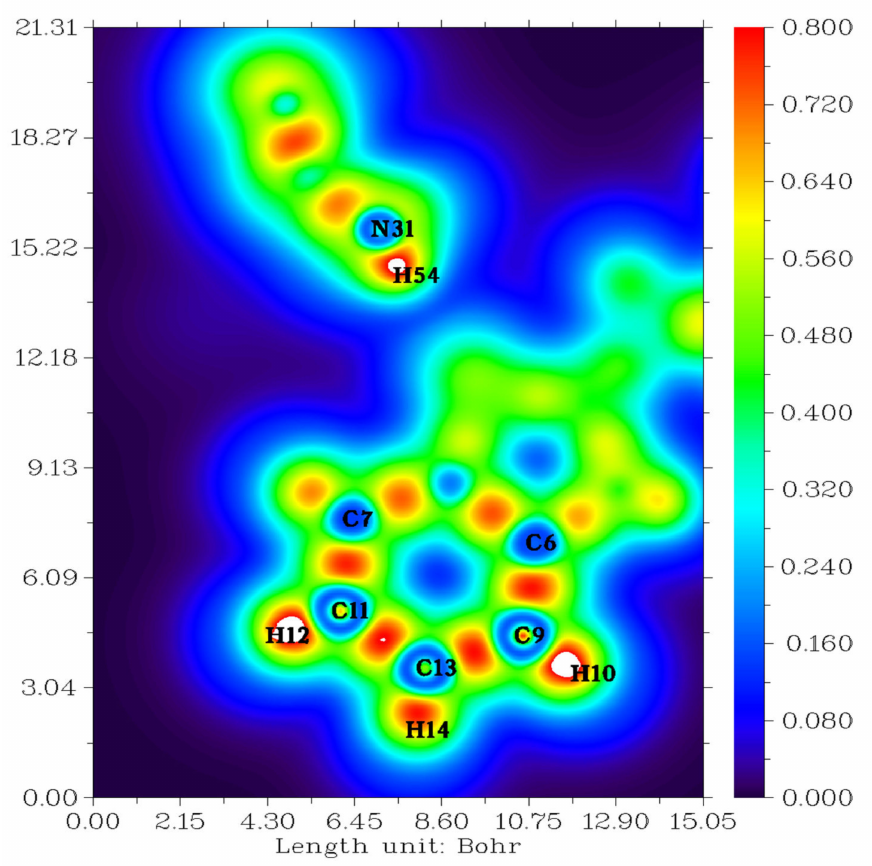
Figure 4. Localized orbital locator (LOL) for our